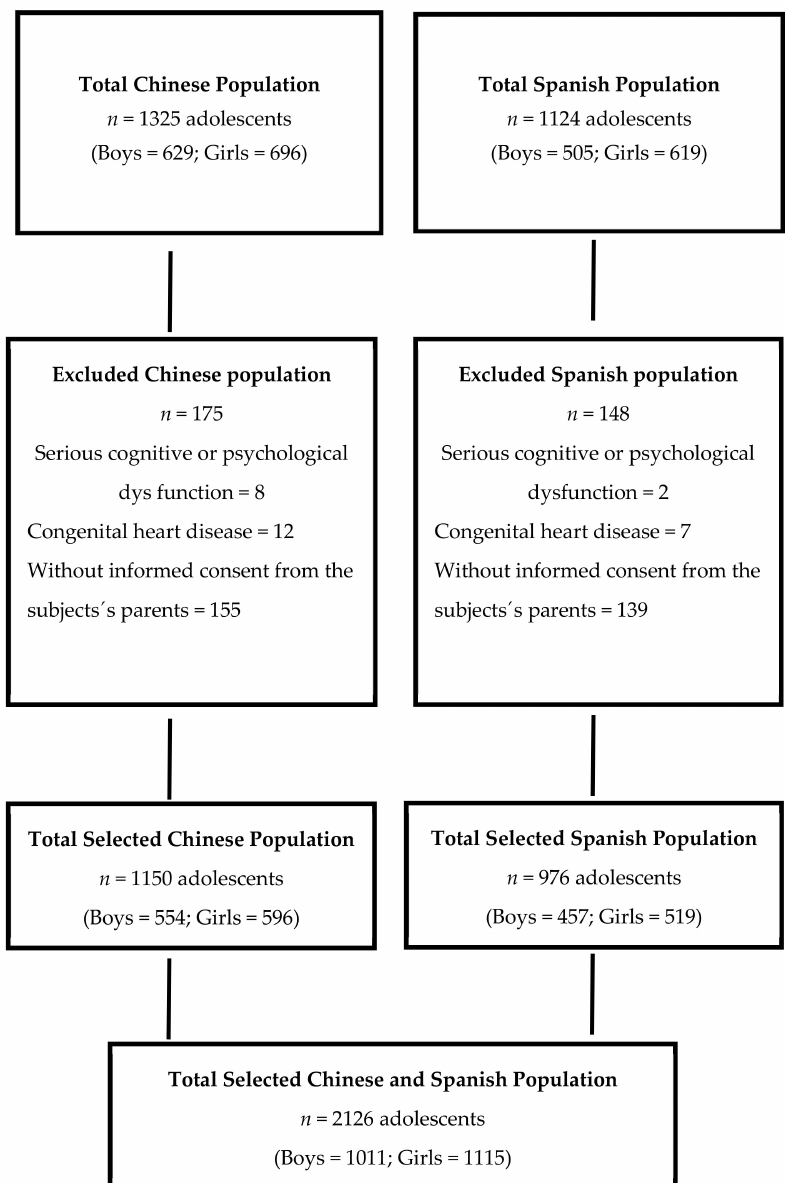
Figure 1. Flow diagram of the recruitment